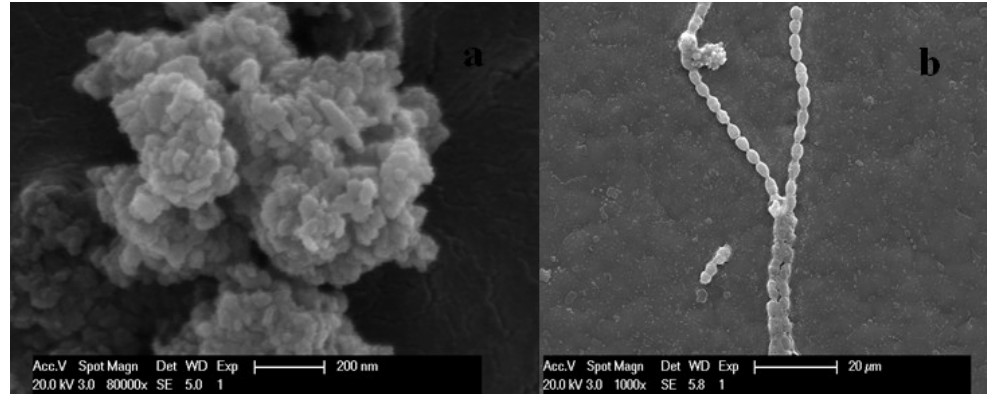
Figure 1. SEM images of ( a ) nano-TiO